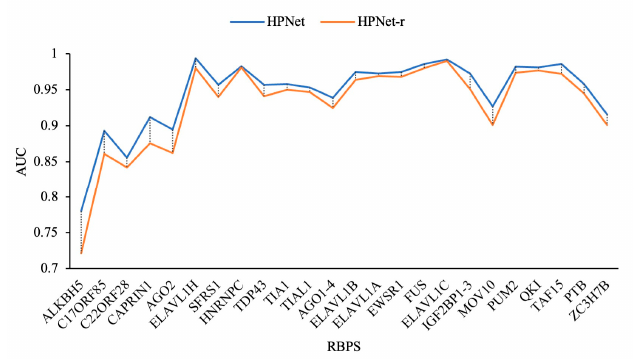
Figure 8. Performance comparison of original dataset and debiased dataset.